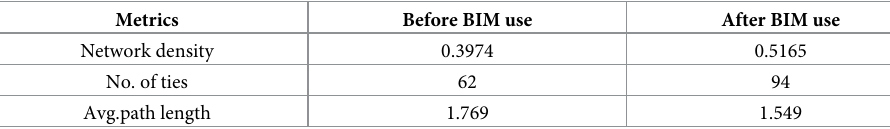
Table 3. Network cohesion metrics analysis